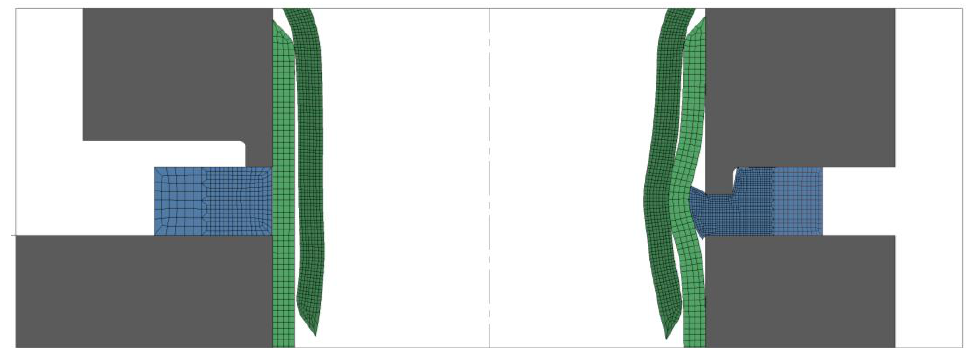
Figure 3. Detail of the finite element model after the upper tube reduction at the start of the sheet flange indentation ( left ) and at the end of the mechanical joining process ( right ). A mechanical connection between two PVC tubes by means of the aluminum sheet flange is depicted.